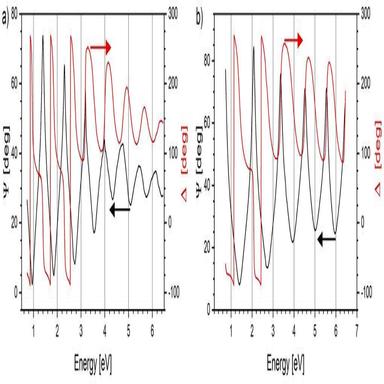
Examples of Psi and Delta spectra recorded within the whole available wavelength range for (a) TEOS_sw, (b) TEOS_BTSE_sw.